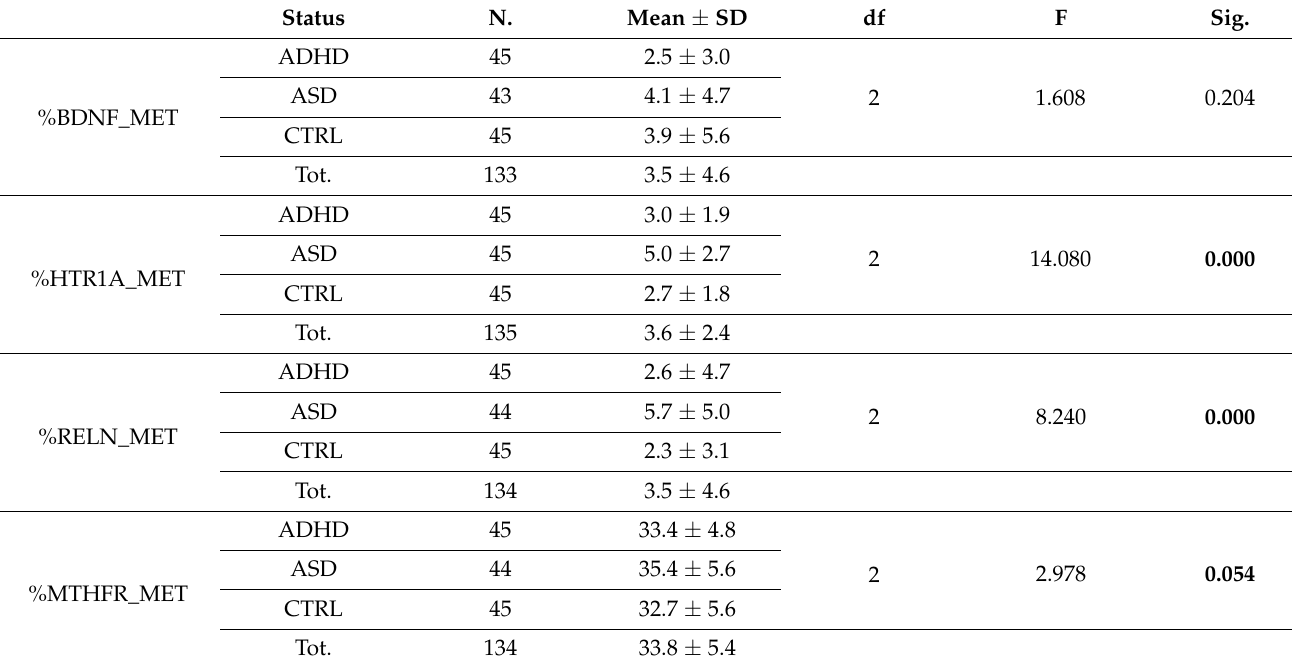
Table 2. ANOVA test results for percentage of methylation of the four studied genes in AS moth- ers, ADHD mothers and healthy control mothers. df = degree of freedom, F = Fisher value, Sig = statistically significant. In bold significant